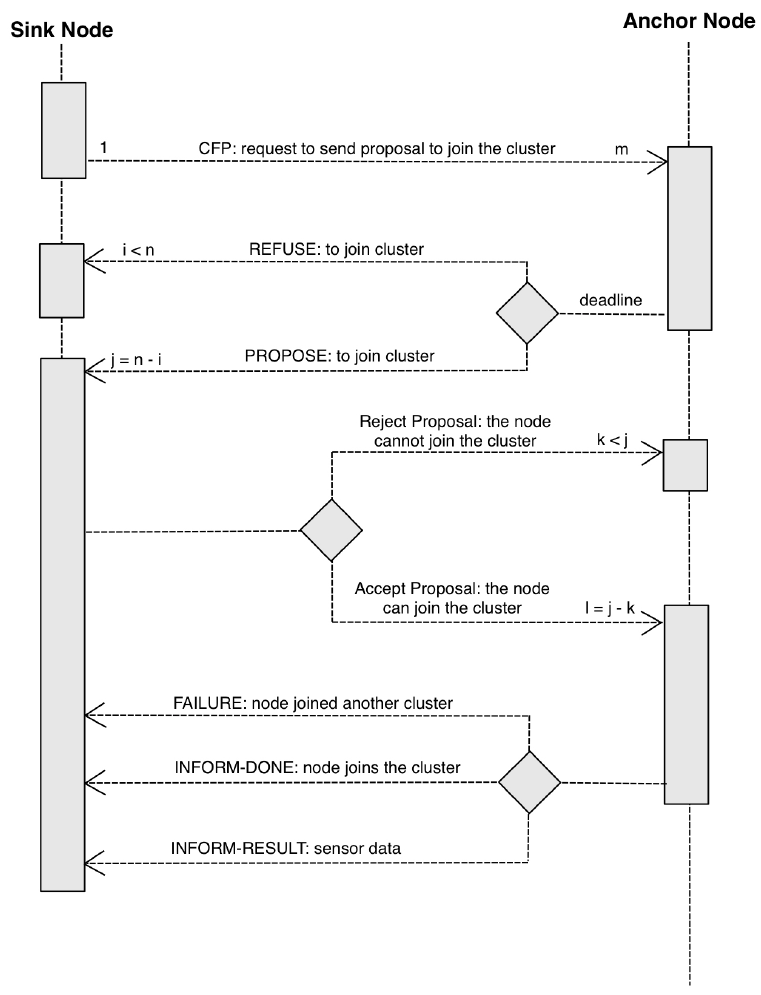
Figure A1. Agent interaction diagram showing distributed cluster formation using the static technique.